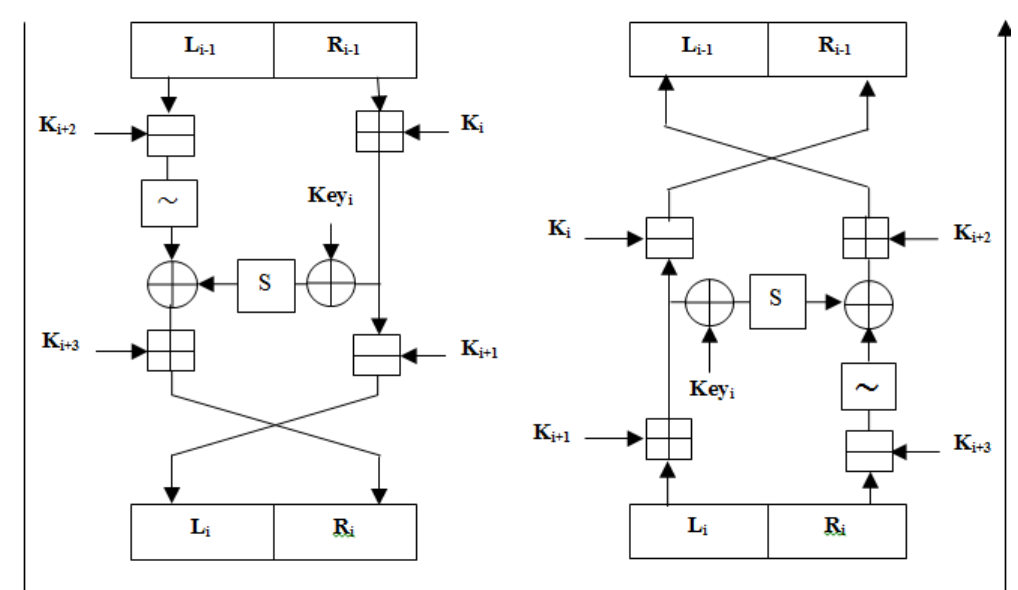
Figure 3. The reversing process for both Encryption and Decryption Algorithm for any Round i